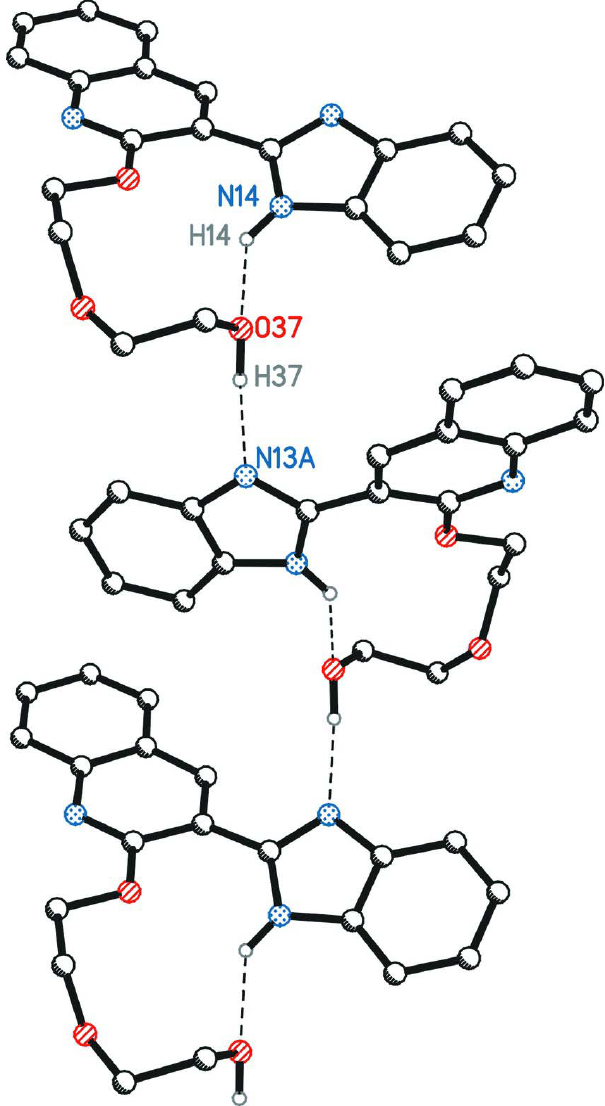
Ball and stick representation of the hydrogen bond connected chain along the b direction. Hydrogen atoms not involved in hydrogen bonds (dashed lines) have been